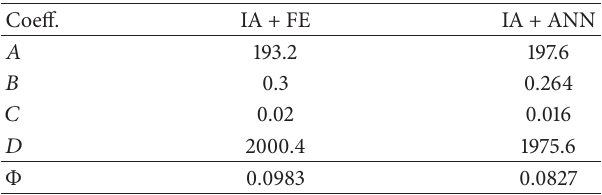
Table 5: Coefficients in (1) determined for CuCr alloy using inverse analysis with the FE model and with the metamodel. Coeff.